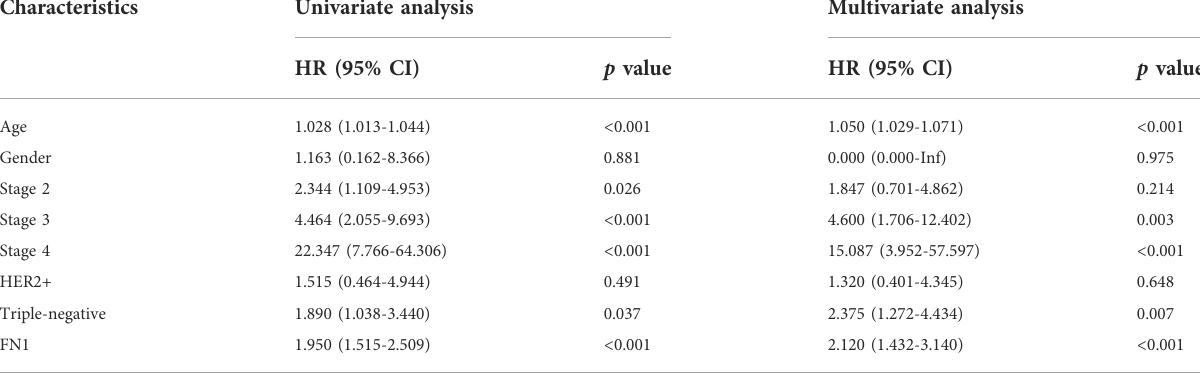
TABLE 3 Relationship between clinicopathological characteristics and breast cancer patient OS through Cox regression analysis based on TCGA.